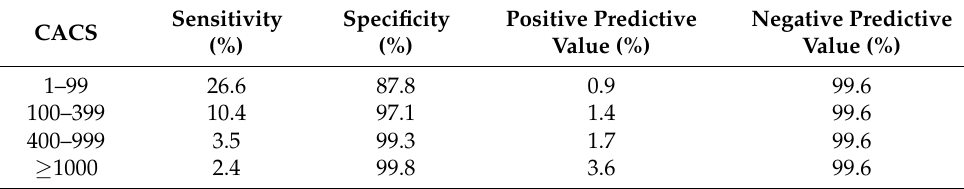
Figure 4. Receiver operating characteristic curve for coronary artery calcium score to predict atrial fibrillation. Table 3. Predictive accuracy of CACS for AF risk.